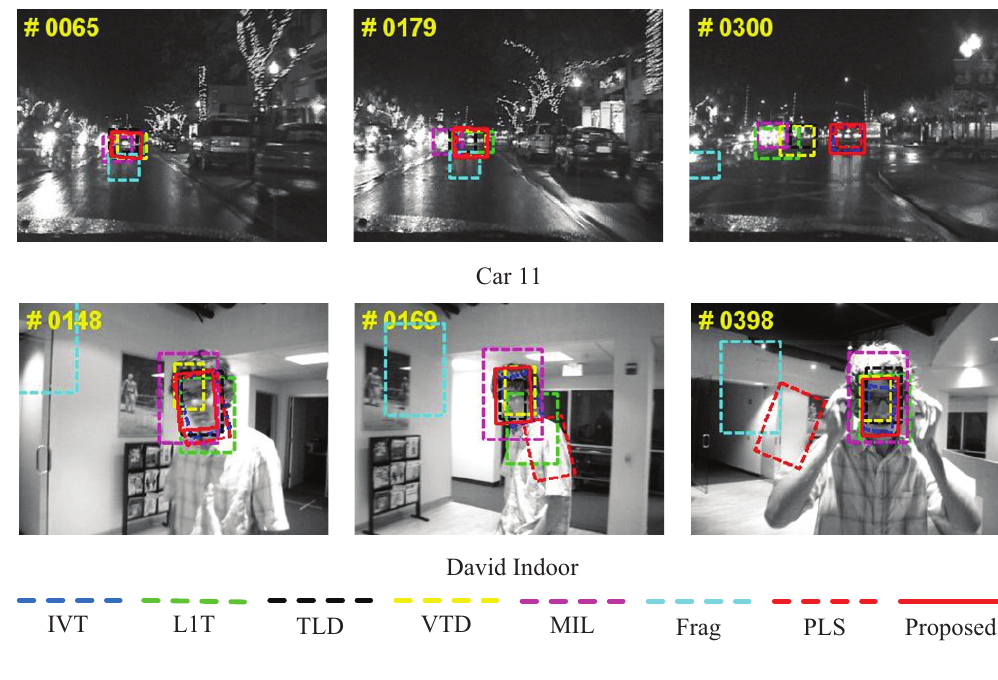
Figure 7. Qualitative evaluation results of eight algorithms on challenging tested sequences Car 11 and David Indoor